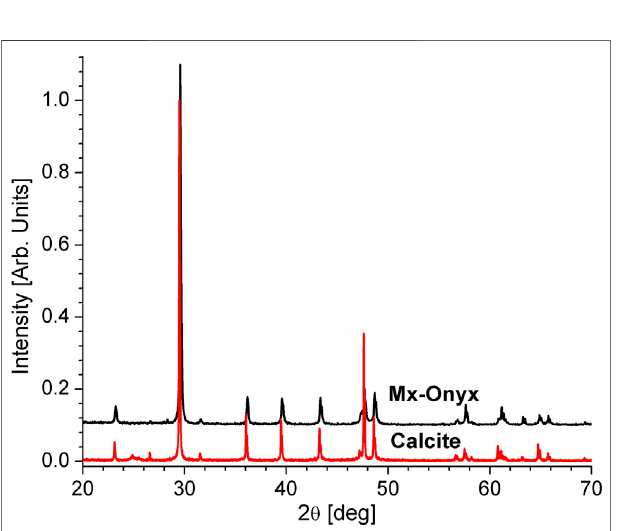
FIGURE 3 | Raman spectrum of Mx-Onyx together with the spectra of calcite, whewellite and gypsum (Lafuente et al., 2015). The vertical dashed lines are an aid to the eye. The enclosed section is an in fi cation of hydration. The peak marked with * corresponds to diamond, while the one marked with ** corresponds to diamond with inclusions of CO 2